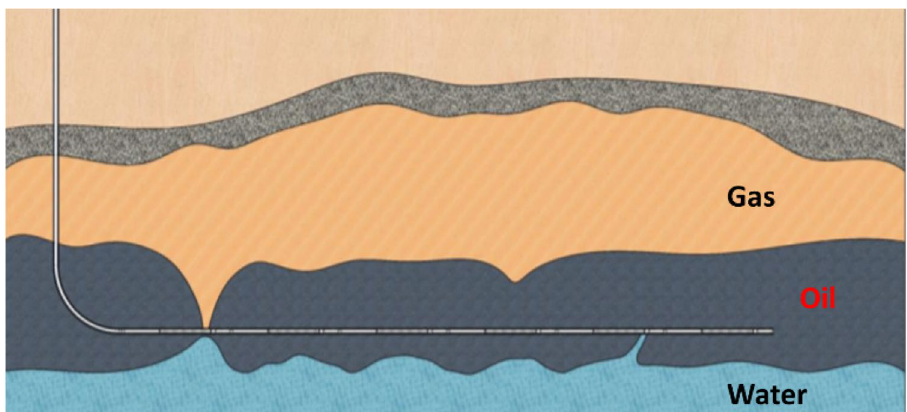
Fig. 1 Schematic of gas and water breakthrough in hetero- geneous reservoir (Mathiesen et al. 2014)